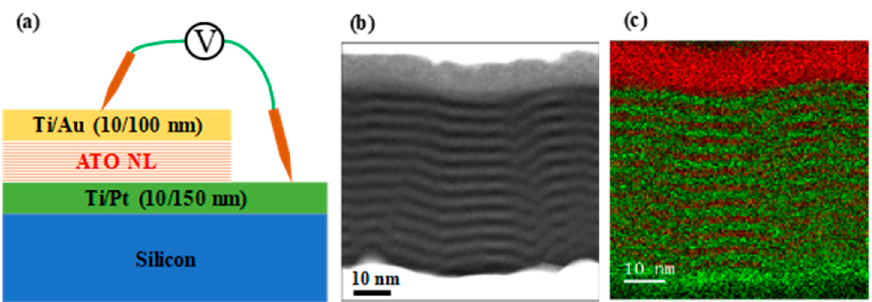
Figure 2. ( a ) Schematic diagram of the Si/Ti/Pt/ATO NL/Ti/Au capacitor. ( b ) STEM image and ( c ) EDX mapping for the 1.98A/2.01T ATO NL layer.